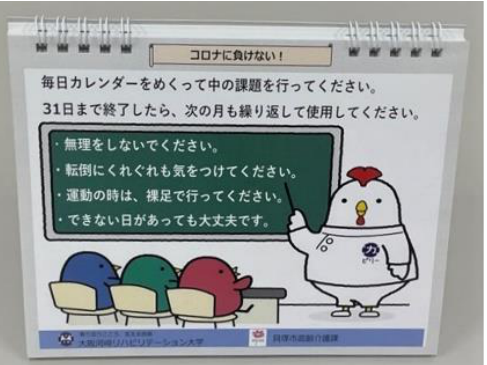
Figure 2. The calendar that was created. Notes on doing calendar assignments are described. Don't